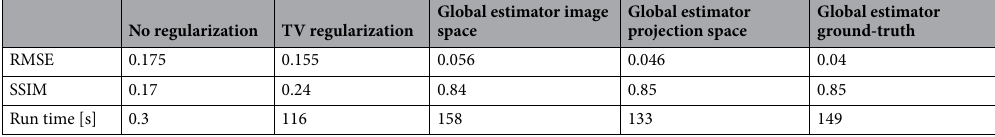
Table 1. Summary of results of simulations for global-estimator with constant